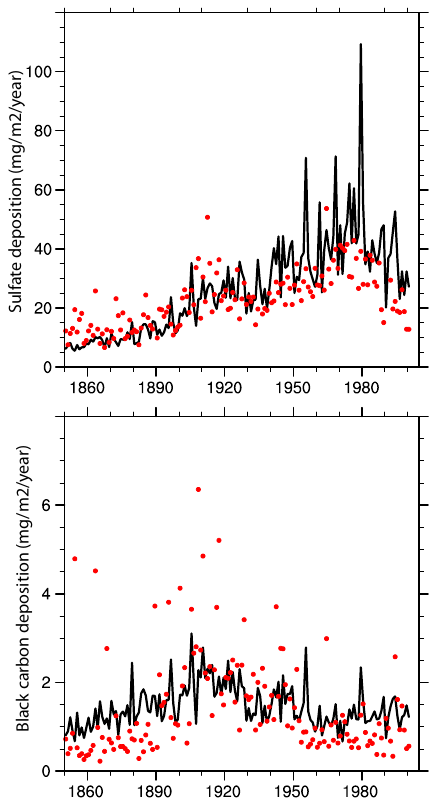
Fig. 13. Deposition (annual average) over Greenland (D4 site) of sulfate and black carbon. Ice-core observations are in red and CAM-chem results are in black.